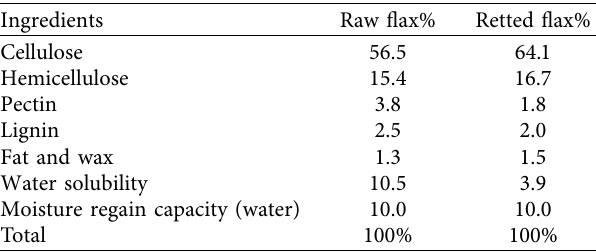
Table 2: Chemical composition of flax fibres.